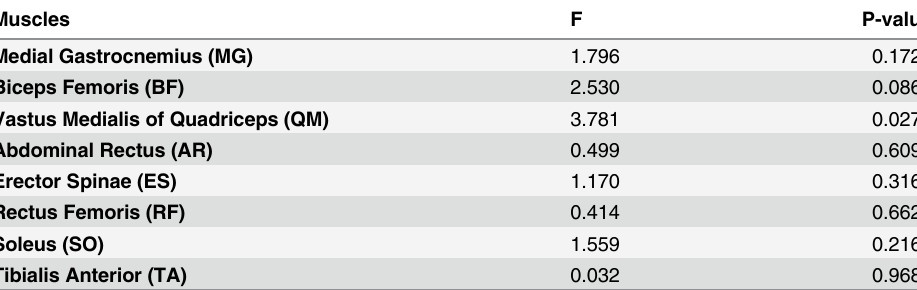
Table 5. ANOVA test for the MF